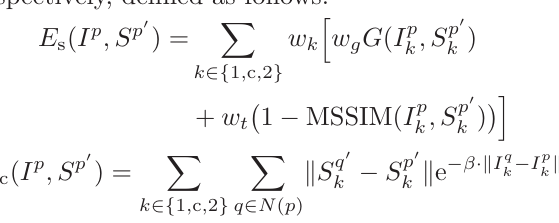
where E s and E c are structure and coherence